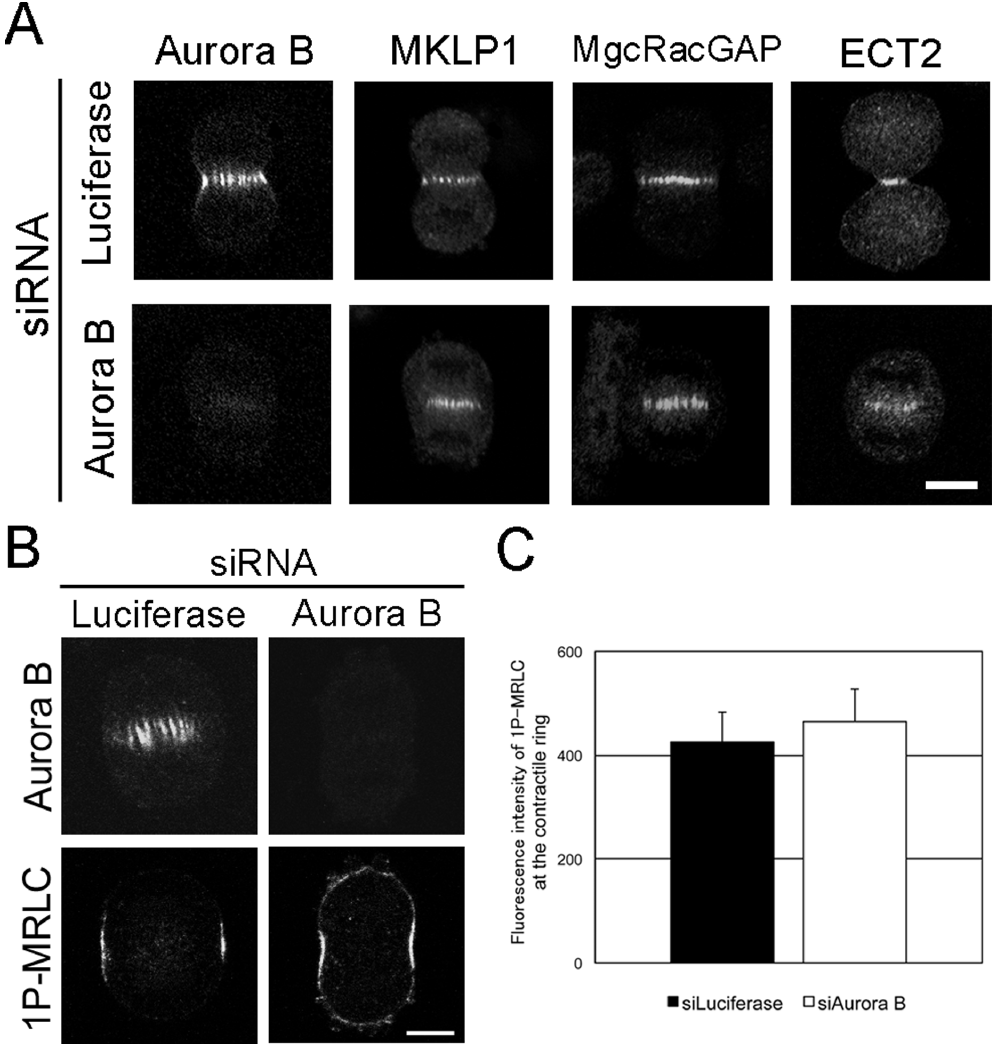
Figure 5. Aurora B is not involved in the localization of 1P-MRLC to the contractile ring. (A and B) HeLa cells treated with either luciferase or Aurora B siRNAs were fixed and immunostained as indicated. Bar, 10 m m. (C) Quantitative analysis of 1P-MRLC fluorescence at the contractile ring in luciferase- or Aurora B-depleted cells. Error bars indicate 6 SEM. n $ 19.